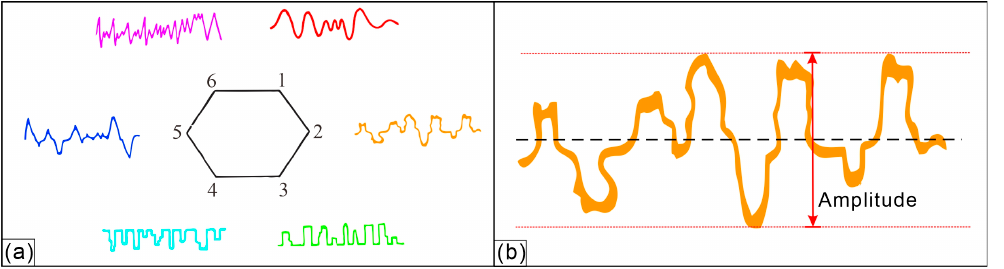
Figure 3. Classification and amplitude of stylolite. ( a ) Classification of stylolite according to the two- geometry of the stylolite itself [29]. 1. Simple or primitive wave-like type; 2. sutured type; 3. up-peak type (rectangular type); 4. down-peak type (rectangular type); 5. sharp-peak type (tapered and pointed); 6. ”seismogram” type. ( b ) Amplitude of stylolite.